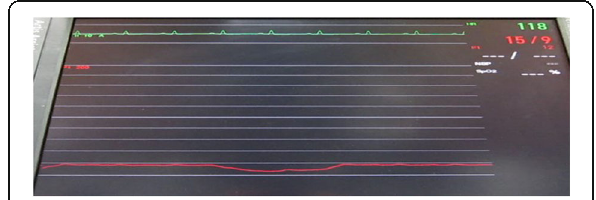
Fig. 2 PCWP wave form in right heart